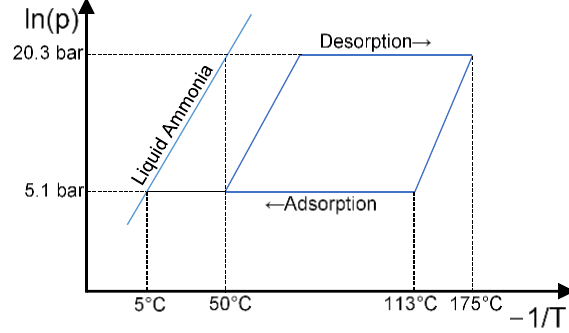
Figure 9. Clapeyron diagram of the typical heat pump cycle.